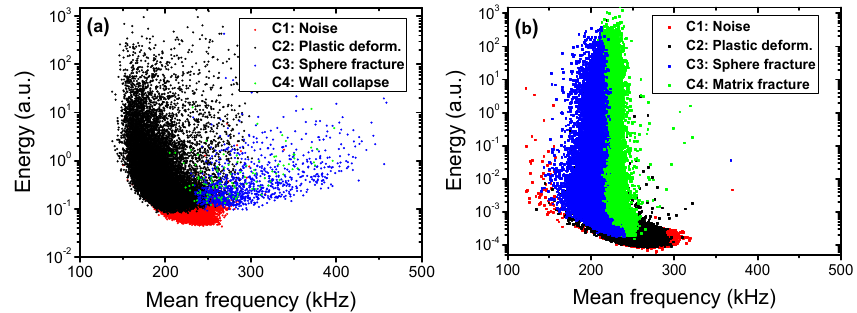
Figure 3. The 2D projection of the clusters to the energy-mean frequency space for ( a ) Al foam; ( b ) AlSi12 foam.